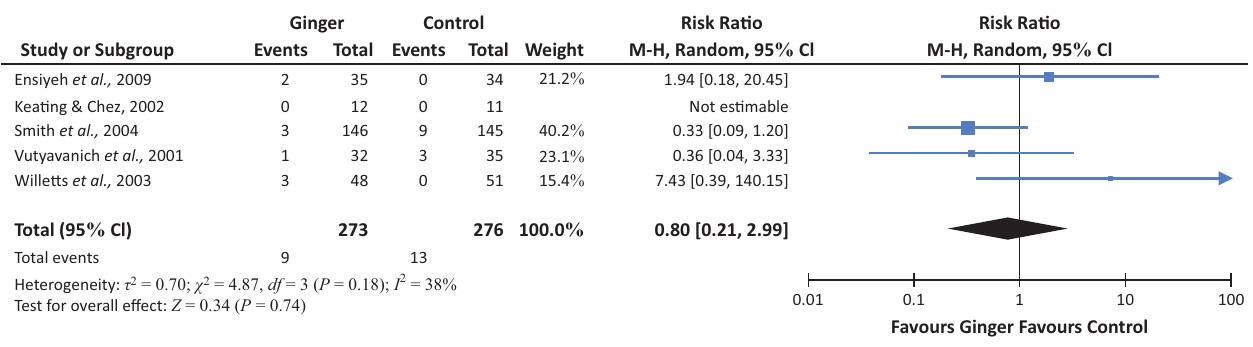
FIGURE 3: Incidence of spontaneous abortion.